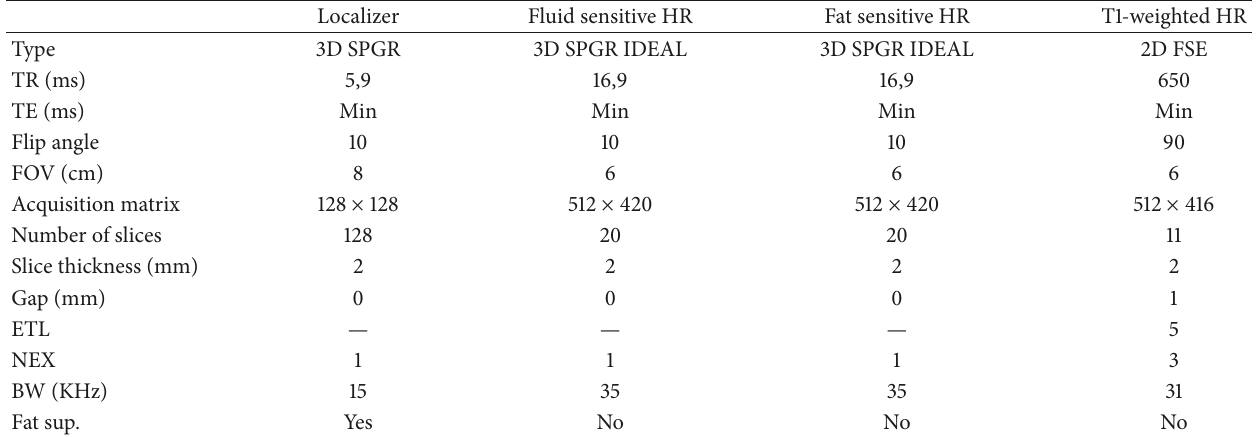
Table 1: Parameters of the MR